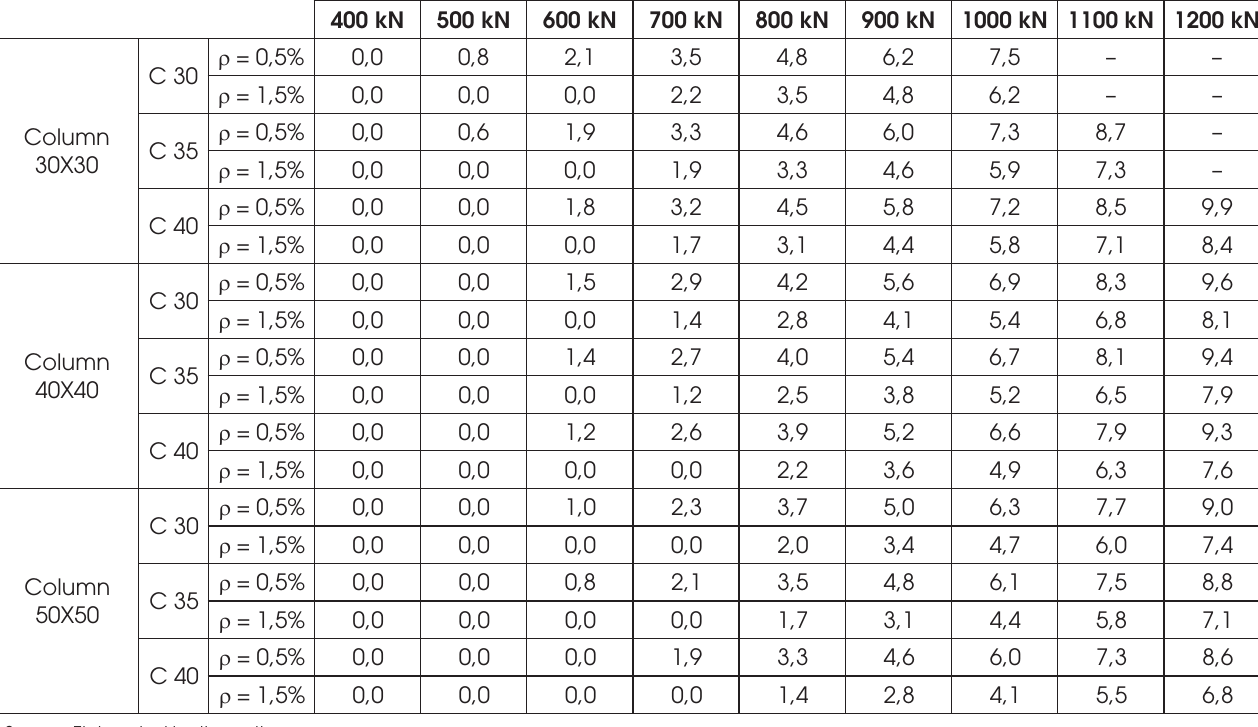
Area of shear reinforcement (cm²) by EC2:2004 (analysis 1)